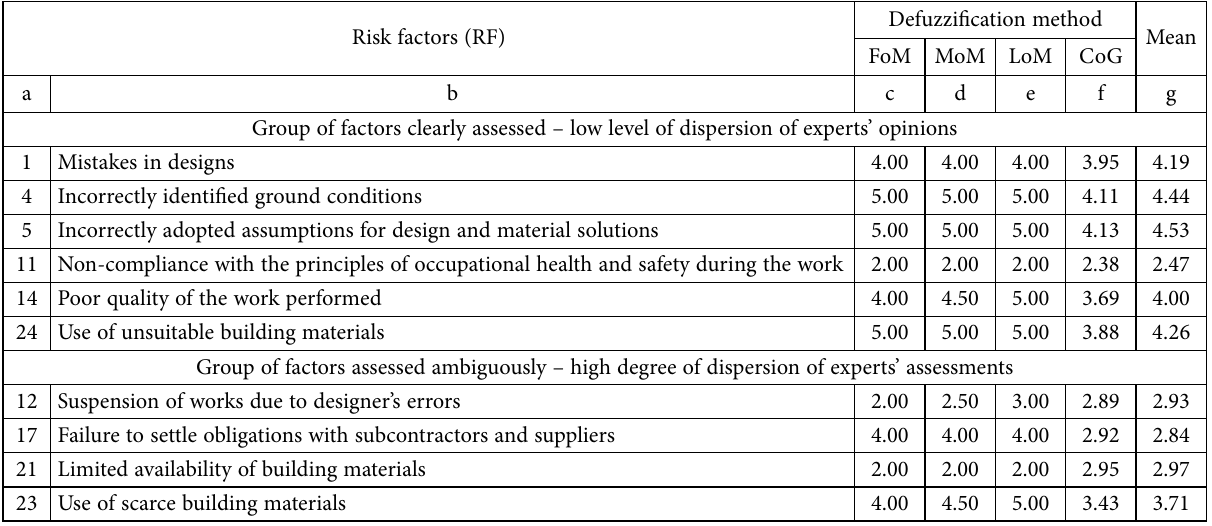
Table 10. In the first group, the coefficients of variation V ranged from 2.31% for factor 1 (mistakes in designs) to 12.16% for factor 14 (poor quality of the work